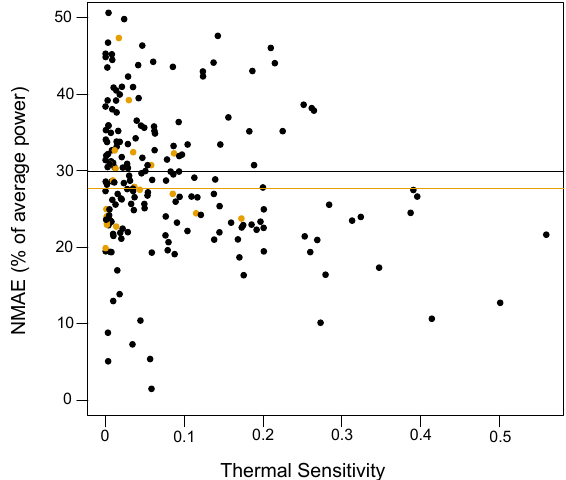
Figure 5. Forecasting performance ( y -axis) for each of the 226 households, regarding their respective thermal sensitivity ( x -axis). The 20 households of the selected Ξ subset are depicted in orange, and the rest in black. The lines represent the median value of the